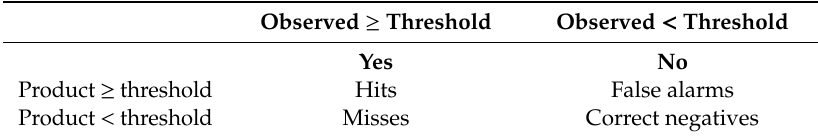
Table 3. Contingency table of rainfall possible